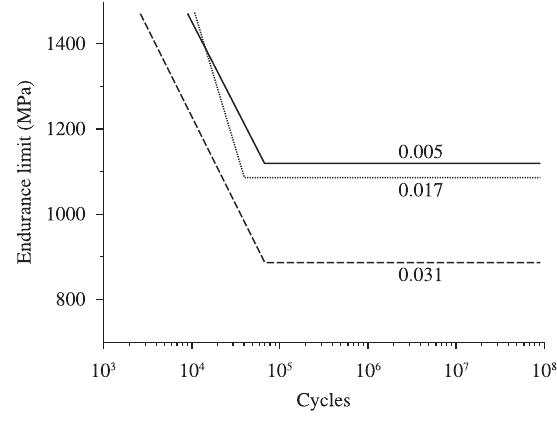
Figure 3. Comparison of maximum stress versus number of cycles for steels with different phosphorus contents 10